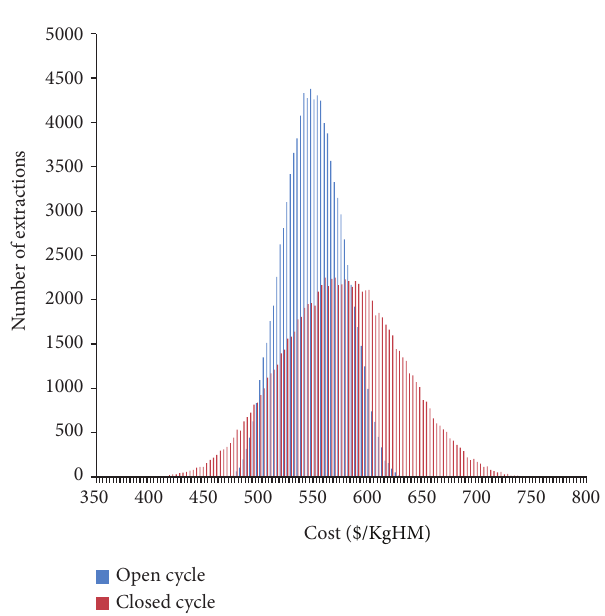
Figure 4: Comparison of the two alternatives for 100.000 extrac- tions.